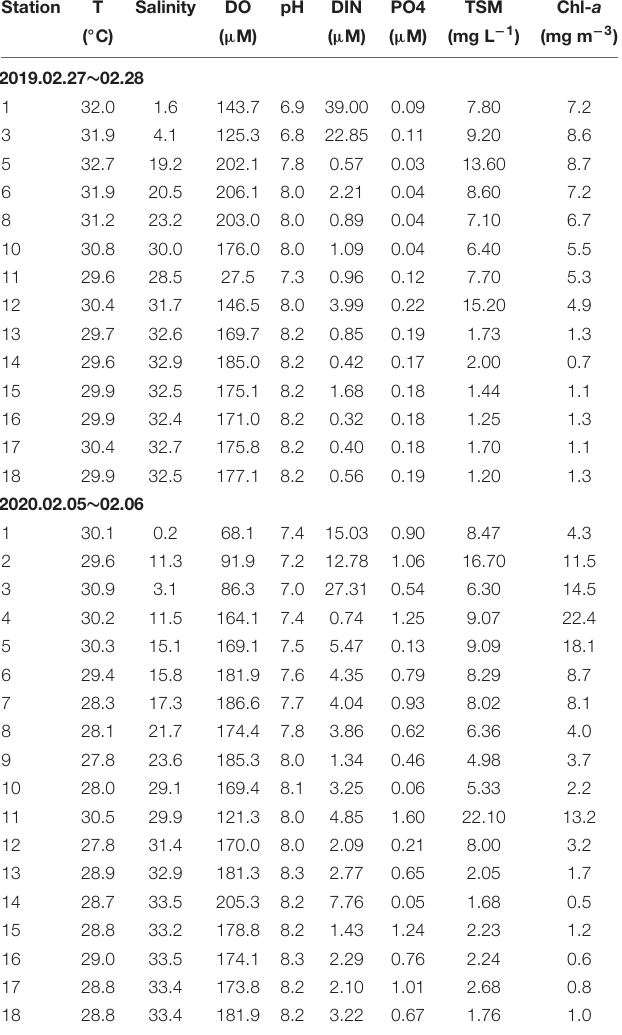
TABLE 2 | Water temperature, salinity, dissolved oxygen (DO), pH, dissolved nitrogen (NO3 + NO2), total suspended matter (TSM) and chlorophyll- a (Chl- a ) in the Negombo Lagoon in the dry season 2019 and 2020.